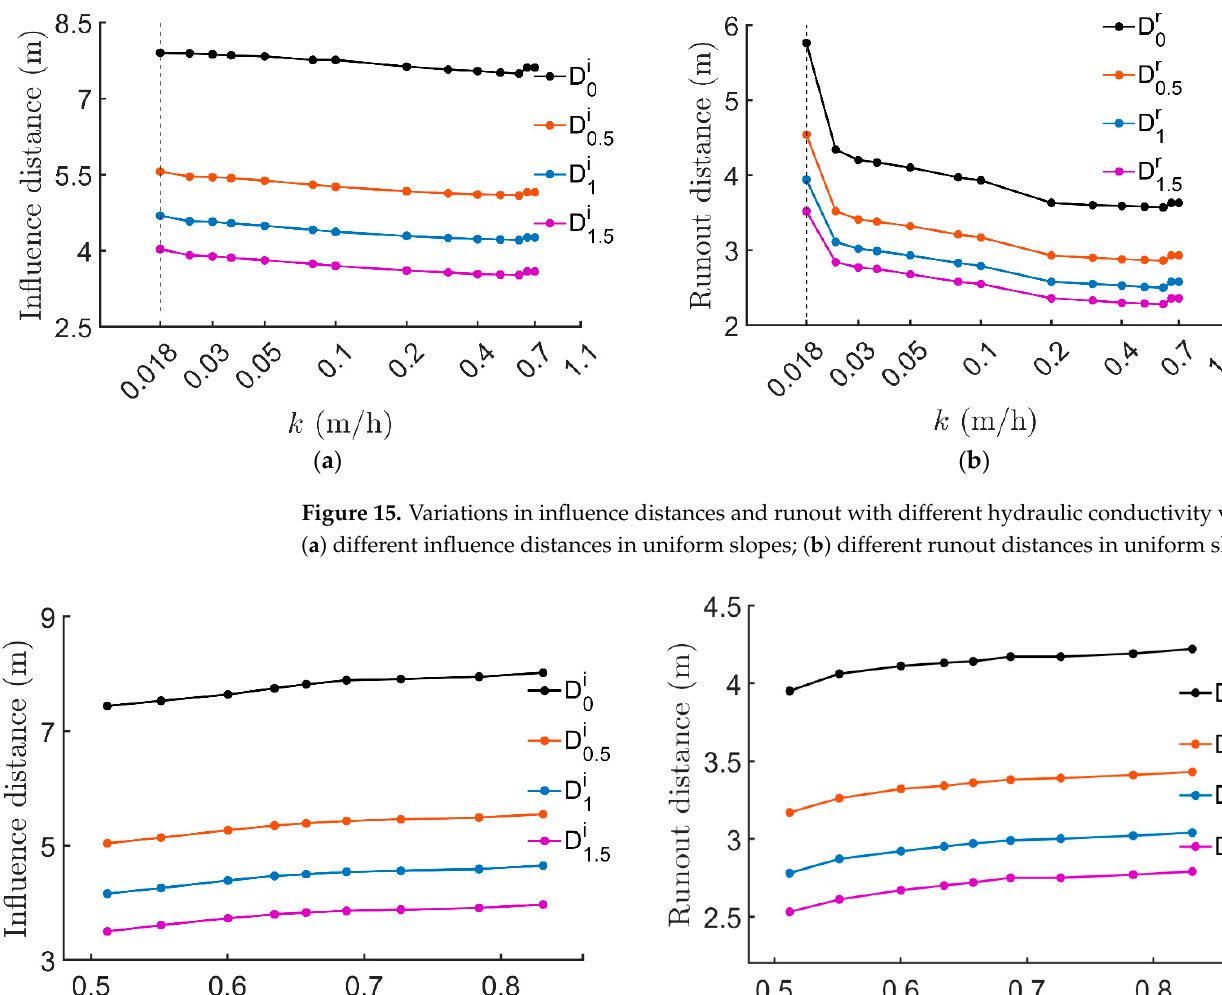
Figure 16. Variations in influence distances and runout with different initial saturation values: ( a ) different influence distances in uniform slopes; ( b ) different runout distances in uniform slopes.